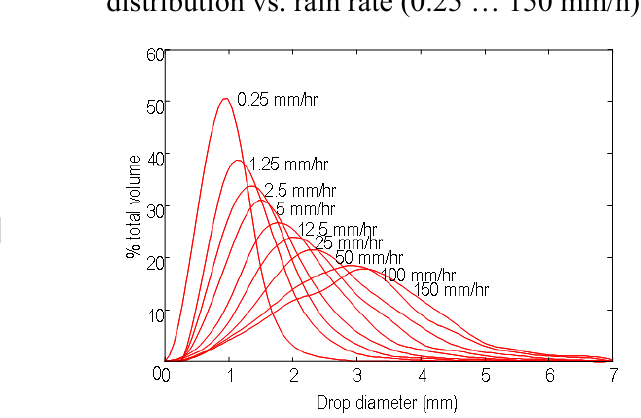
Figure 1b. Laws and Parsons equivalent radii distribution vs. rain rate (0.25 … 150